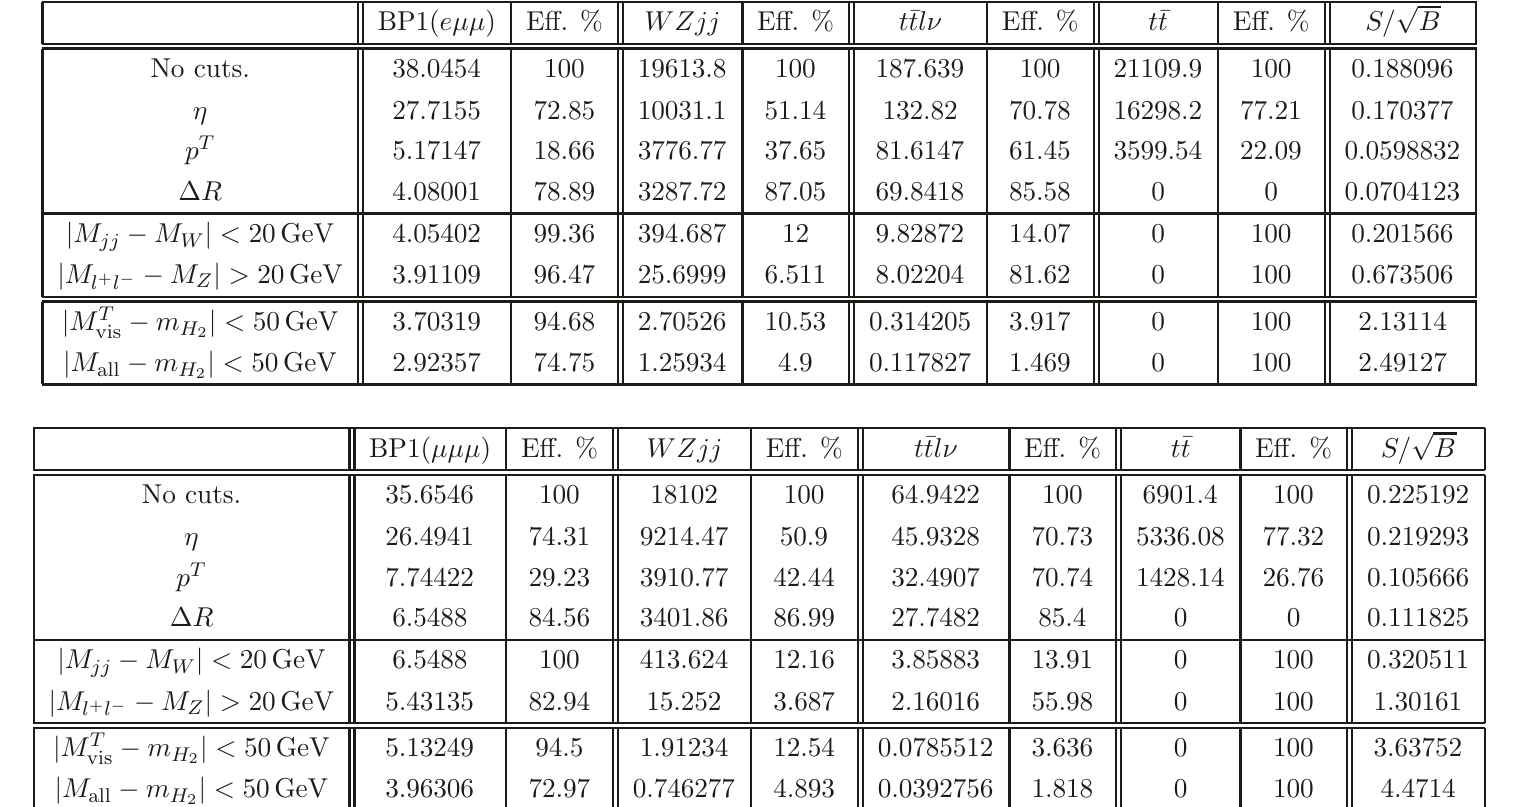
Table 3 . Benchmark point BP1. Luminosity ∆ R lj > 0 . 4 + ∆ R ll > 0 . 3. Transverse momentum cuts for the eµµ category: p T category: p T > 14GeV, p T > 12 GeV and p T µ 1 µ 2